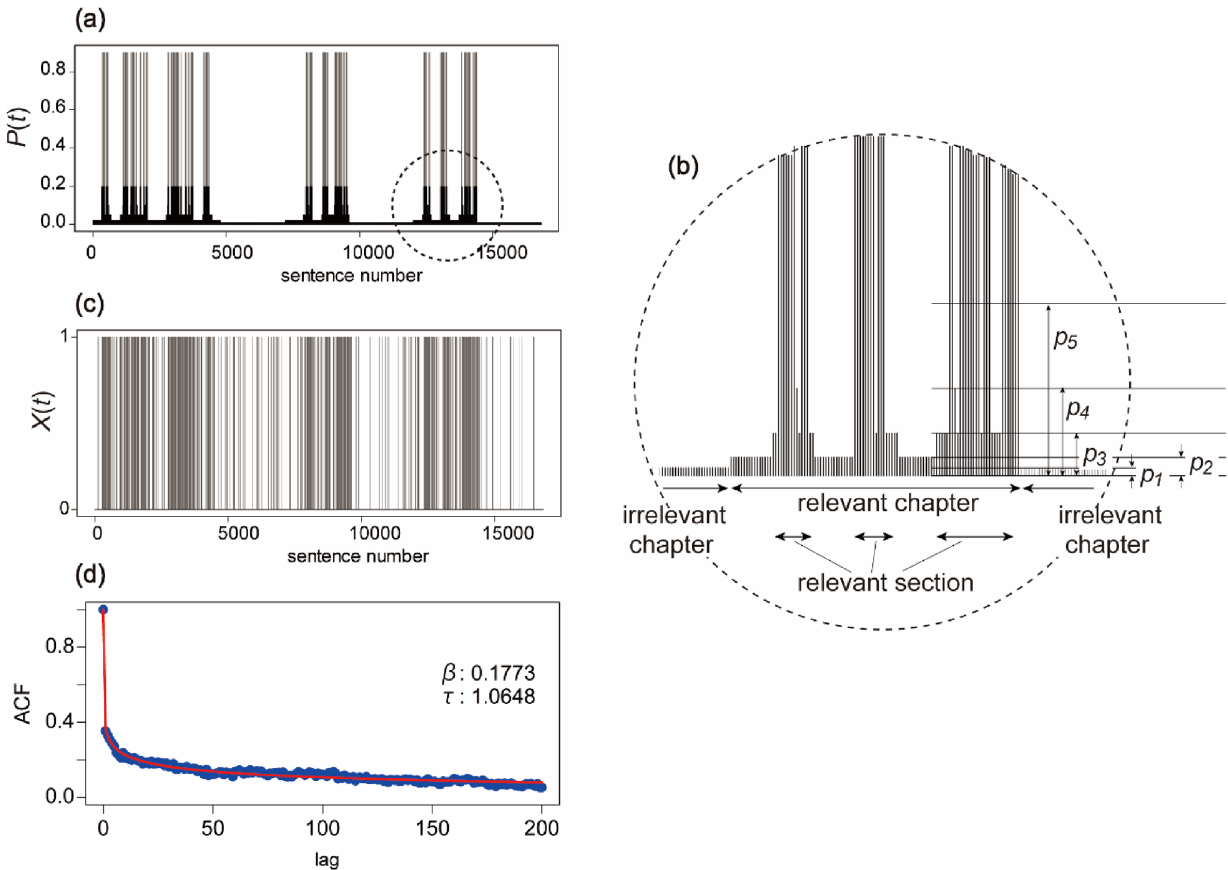
Fig. 5 Results of word occurrence simulation. ( a ) Simulated occur- rence probability of a considered word in a text, which is con- structed by a recursive algorithm. ( b ) Enlarged view of the dotted circle in ( a ). ( c ) Occurrence signal X ( t ) of the considered word in the